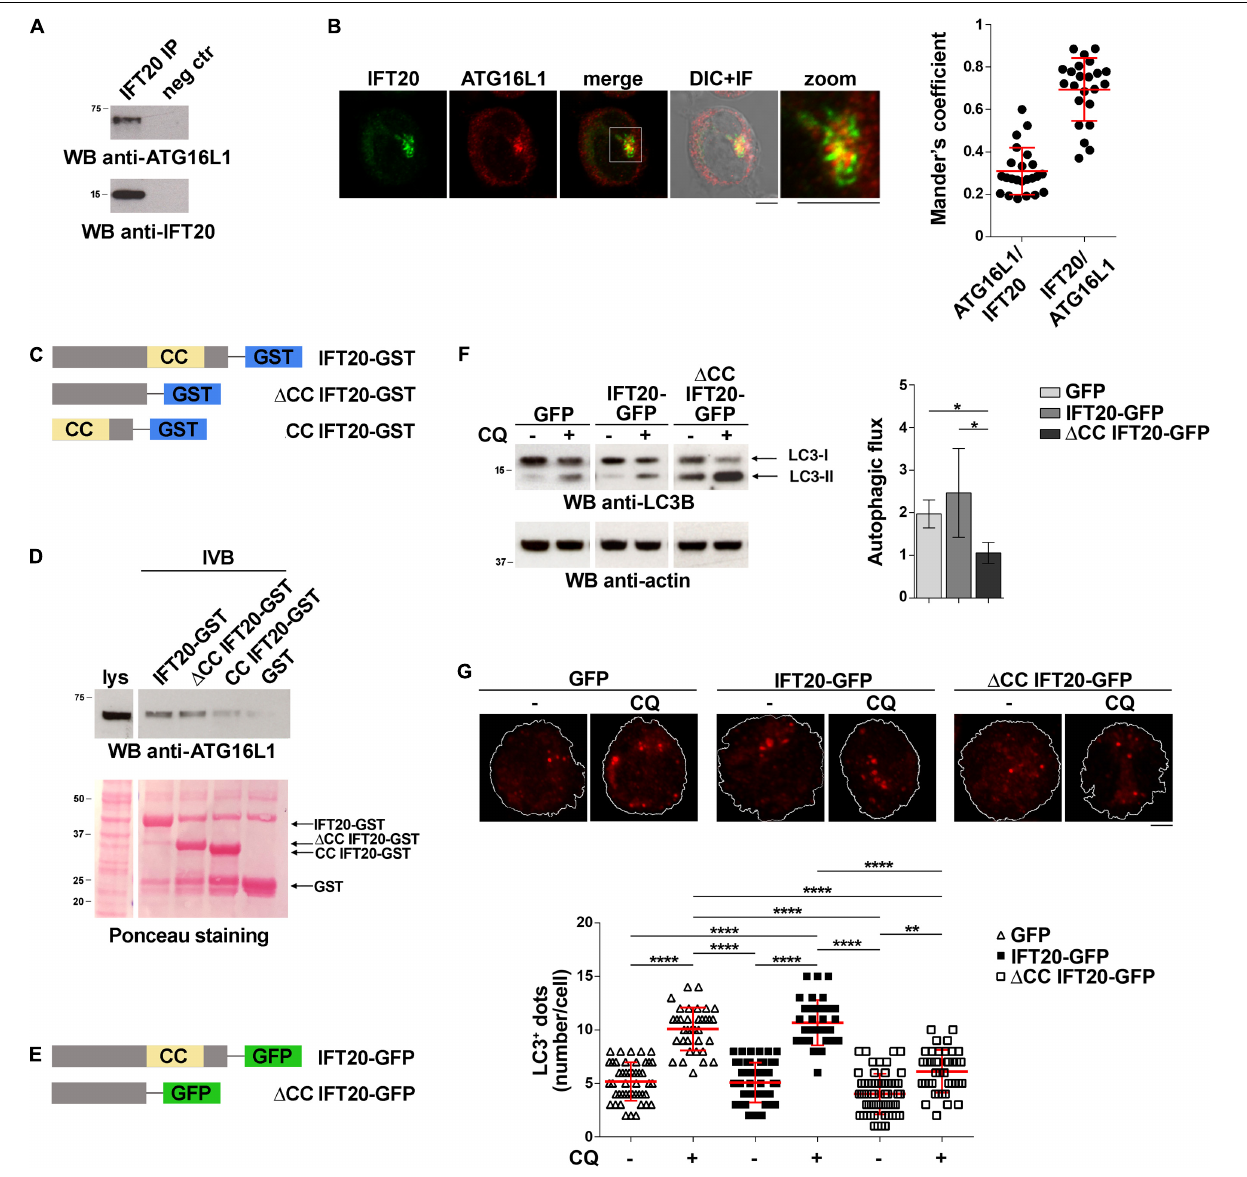
FIGURE 1 | IFT20 binds to ATG16L1 and promotes T cell autophagy through its CC domain. (A) Western blot (WB) analysis with anti-ATG16L1 antibodies of IFT20-specific immunoprecipitates from lysates of Jurkat T cells. A preclearing control (proteins bound to Protein-A–Sepharose before the addition of primary antibody) is included in each blot (neg ctr). The migration of molecular mass markers is indicated. The immunoblots shown are representative of at least 3 independent experiments. (B) Immunofluorescence analysis of IFT20 and ATG16L1 in Jurkat cells. Representative medial optical sections and overlay of immunofluorescence (IF) and differential interference contrast (DIC) images are shown (IF + DIC). The graph shows the quantification (using Mander’s coefficient) of the weighted colocalization of IFT20 and ATG16L1 in Jurkat cells. The data are expressed as mean ± SD (23 cells/sample; n = 3). Scale bars: 5 µ m. (C) Schematic representation of the GST fusion proteins with full-length IFT20 (IFT20-GST), or the full-length protein lacking the CC domain ( (cid:49) CC IFT20-GST) or the CC domain (CC IFT20-GST). The CC domain is highlighted as a yellow box. (D) Immunoblot analysis with anti-ATG16L1 antibodies of in vitro -binding assays carried out on post-nuclear supernatants of Jurkat cells using IFT20-GST, (cid:49) CC IFT20-GST, and CC IFT20-GST fusion proteins, or GST as negative control. The Ponceau red staining of the same filter is shown to compare the levels of fusion proteins and GST used in the assay. The immunoblot shown is representative of three independent experiments. (E) Schematic representation of the GFP fusion protein with IFT20 (IFT20-GFP) or with the full-length protein lacking the CC domain ( (cid:49) CC IFT20-GFP). The CC domain is highlighted as a yellow box. (F) Immunoblot analysis of LC3B in lysates of Jurkat cells expressing GFP, IFT20-GFP, or (cid:49) CC IFT20-GFP in the presence or absence of chloroquine (CQ, 40 µ M). The migration of molecular mass markers is indicated. The graph shows the autophagic flux in Jurkat transfectants, calculated as the difference in the levels of LC3II/actin between CQ-treated and CQ-untreated samples (mean fold ± SD; one-way ANOVA; n ≥ 3). (G) Immunofluorescence analysis of LC3B in Jurkat cells expressing GFP, IFT20-GFP, or (cid:49) CC IFT20-GFP either untreated or treated for 30 min with chloroquine (CQ, 40 µ M). The z -projection of maximum intensity and the quantification of the number of LC3 + dots/cell are shown. At least 35 cells from three independent experiments were analyzed (mean ± SD; Kruskal–Wallis test). * P < 0.05; ** P < 0.01; **** P < 0.0001.